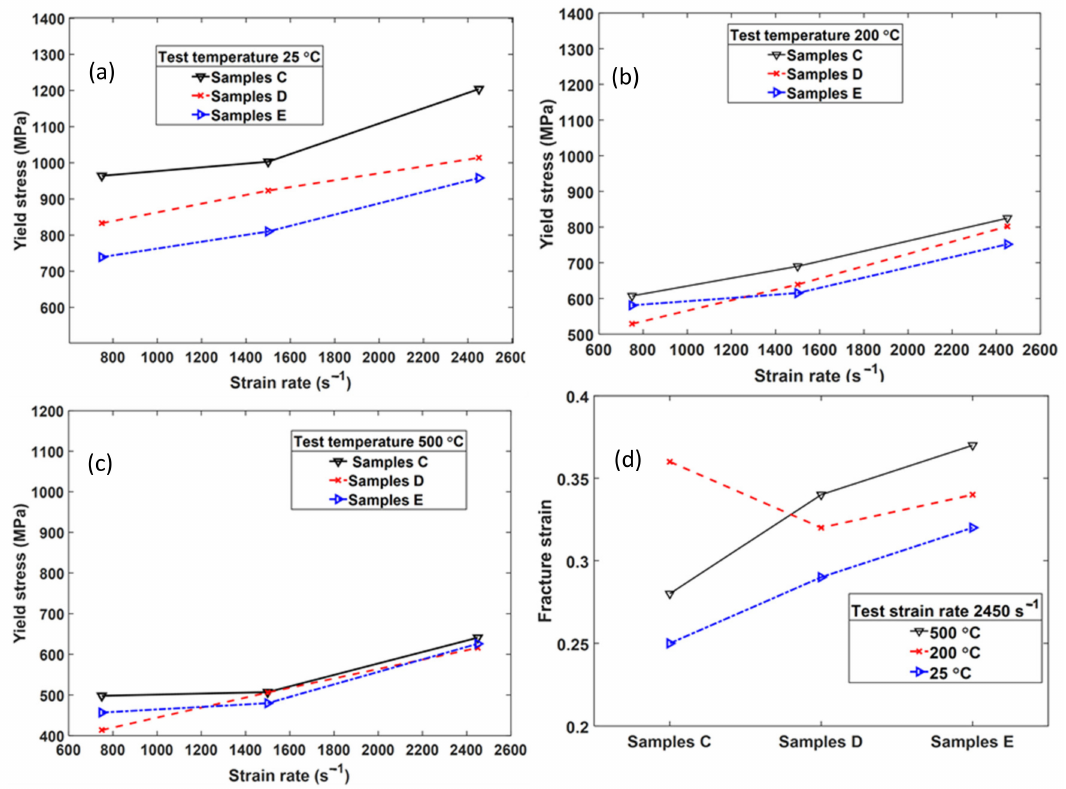
Figure 10. Comparison of ( a – c ) yield stresses under different high strain rates and ( d ) fracture strains at the strain rate of 2540 s − 1 and different temperatures for samples C, D and